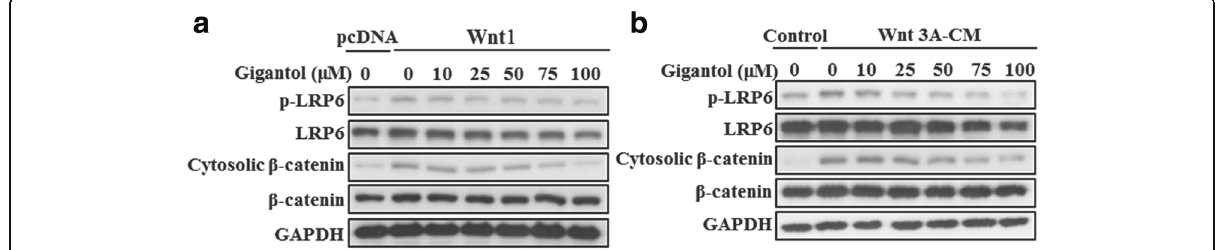
Fig. 3 Gigantol inhibits the Wnt/ β -catenin signaling cascade in HEK293T cells. a The expression plasmid encoding Wnt1 was transfected into HEK293T cells. The cells were then incubated with the indicated concentrations of gigantol for 24 h. b HEK293T cells were treated with the control medium, Wnt3A-CM containing DMSO or the indicated concentrations of gigantol for 24 h. Phosphorylated LRP6, total LRP6, cytosolic β -catenin and total β -catenin were detected by immunoblotting